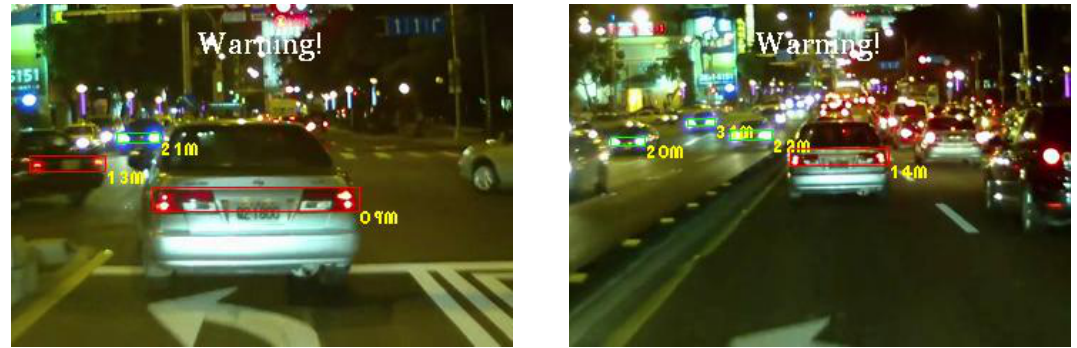
Figure 21. Results of vehicle detection and event determination for a nighttime urban road under bright illumination and congested traffic conditions (Test video 5).